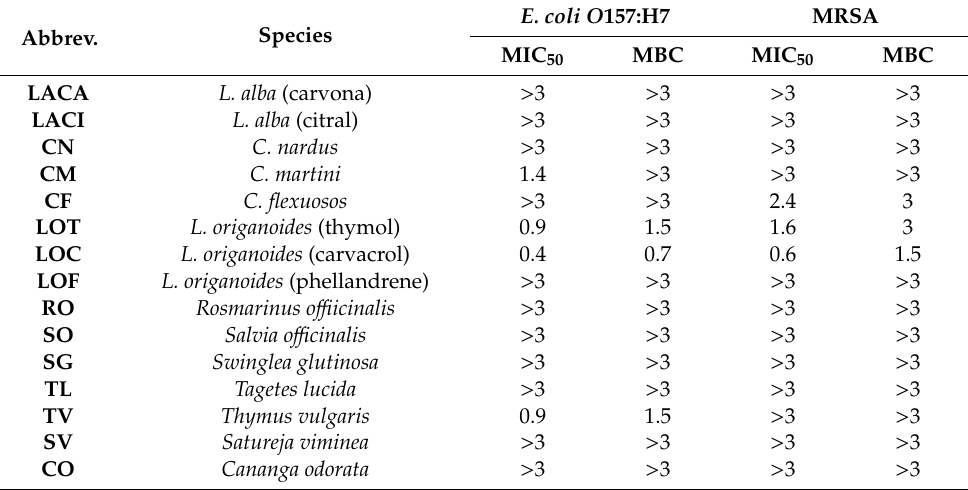
Table 2. MIC 50 and MBC of 15 EOs against E. coli O157:H7 and MRSA. values are expressed in mg / mL, with experiment performed in triplicate ( n = 3).